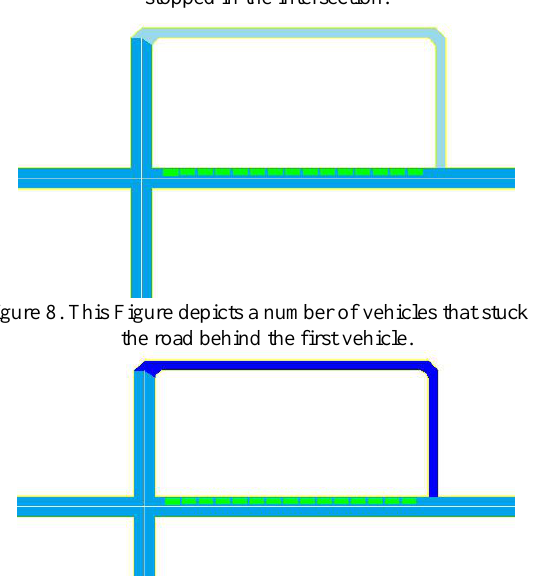
Figure 7. This figure shows a sketch road network that a vehicle stopped in the intersection.